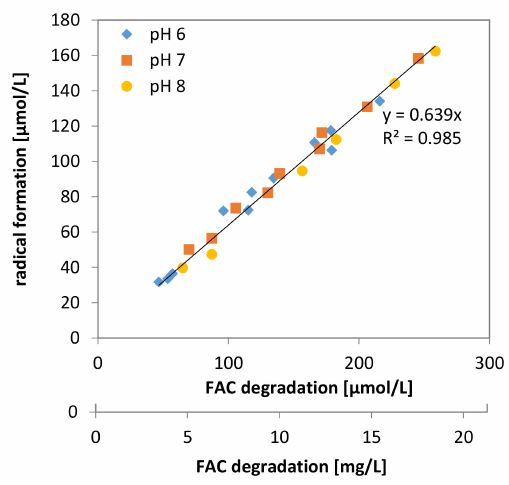
Figure 8. Radical formation in dependence of FAC demand at di ff erent pH (Q = 75 L / h, EC = 400 µ S / L, T = 19 ± 1 ◦ C) ( n =